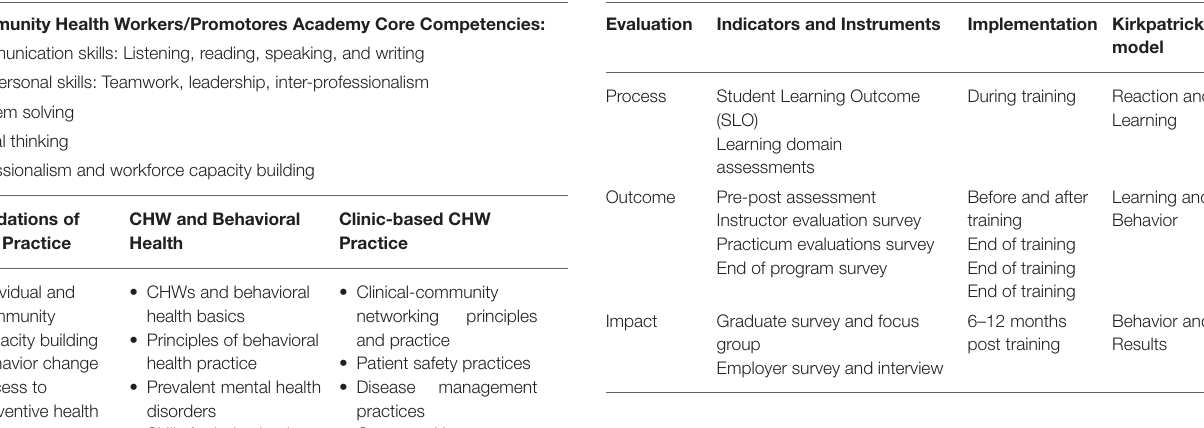
TABLE 2 | Training program evaluation and Kirkpatrick model